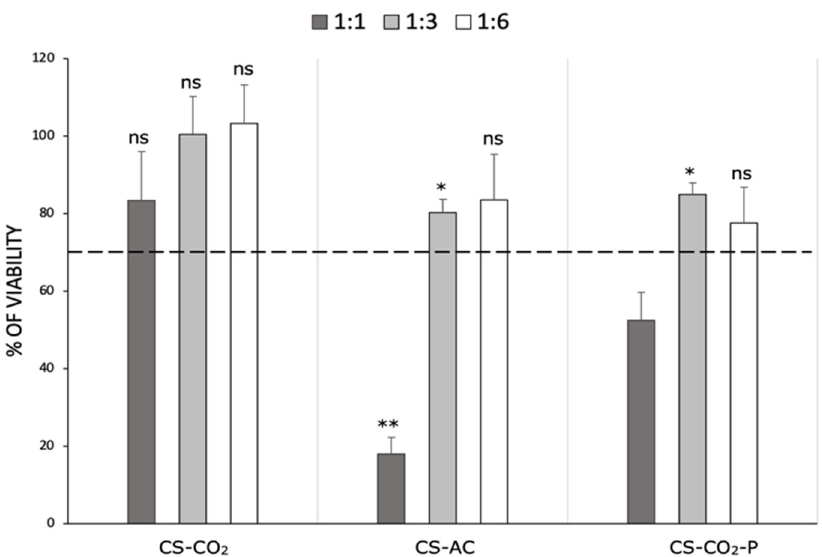
Figure 4. The cytotoxicity of chitosan hydrogels: chitosan dissolved by CO 2 saturation method (CS-CO 2 ), chitosan dissolved in hydroxyacetic acid (CS-AC), and chitosan hydrogel purified by M1 method (CS-CO 2 -P) following 24 h of incubation at different dilution factors (1:1, 1:3, and 1:6) against L929 cells. Data are expressed as the mean ± standard deviation of three independent experiments. The results were analyzed by two-way ANOVA with Dunnett’s multiple comparisons vs. Control: ns (not statistically significant, p > 0.05), * p < 0.01, ** p < 0.001.